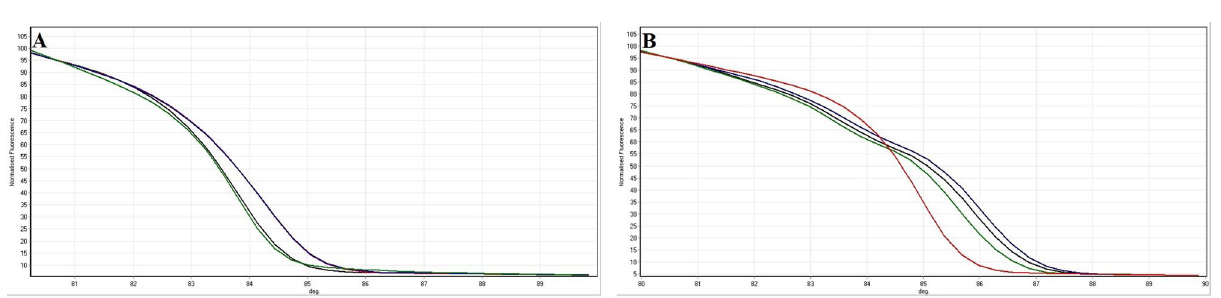
Figure 3. Normalised melting curves of the reference strains of Shigella species analysed by PCR-HRM using ( A ) purA-F-R and ( B ) rrsA-F-R primer pairs. Green curve: S. dysenteriae . Red curve: S. flexneri . Blue curve: S. boydii . Black curve: S. sonnei .